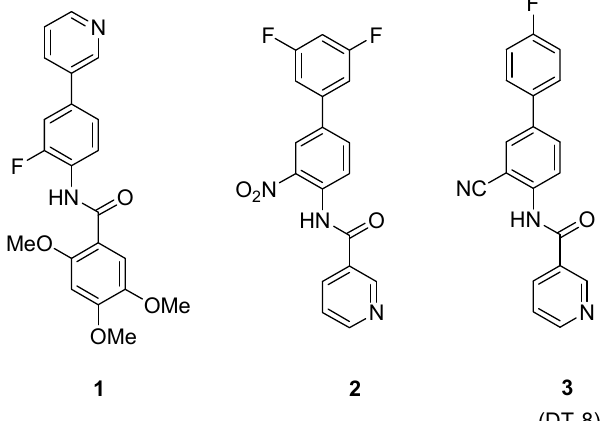
Figure 1. Structure of the hit 2,4,5-trimethoxybenzanilide 1 leading to the nicotinamide derivatives 2 and 3 (lab code: DT-8), the latter acting as in vitro potent nanomolar antiproliferative agent in the human breast cancer MCF-7 and MDA-MB231 cell lines.